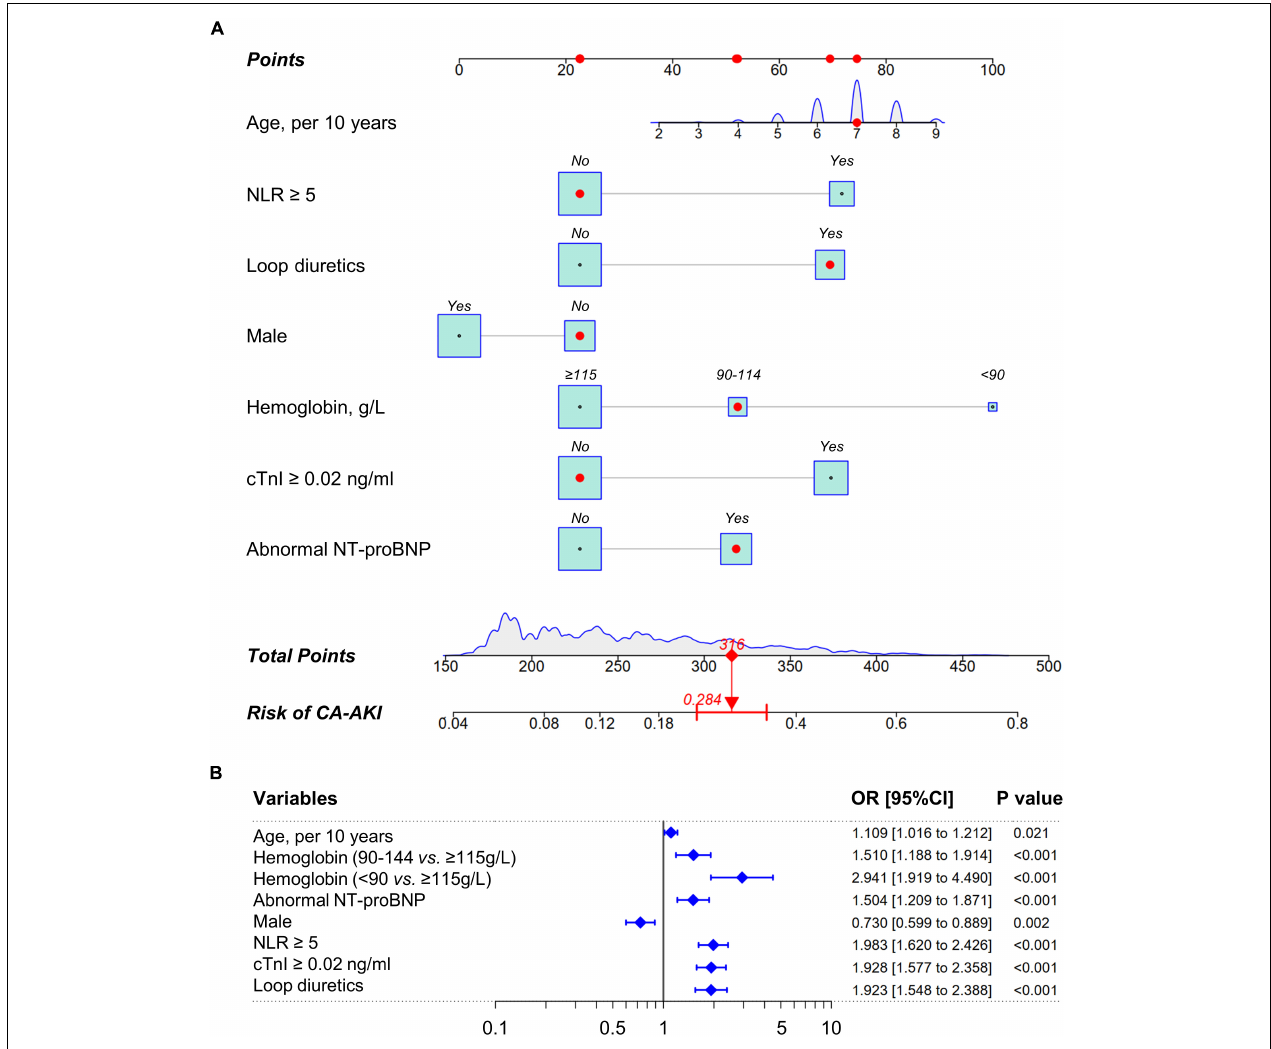
FIGURE 3 | Nomogram to estimate the probability of CA-AKI. (A) A nomogram of CA-AKI established by pre-procedural routine data. The point of each predictive variable is determined by the corresponding location at the uppermost scale. Total points are the sum of each predictor. Total points of each patient indicate the corresponding probability of suffering CA-AKI after CAG/PCI procedural. The density plot or the box size for each predictor reflect population distribution in training dataset. The red marker depicts how to use this nomogram. (B) The forest plot of nomogram predictors. CRP indicates C-reactive protein; cTnI, cardiac troponin I; NT-proBNP, N-terminal of the prohormone brain natriuretic peptide; NLR, neutrophil-to-lymphocyte ratio; CA-AKI, contrast-associated acute kidney injury.